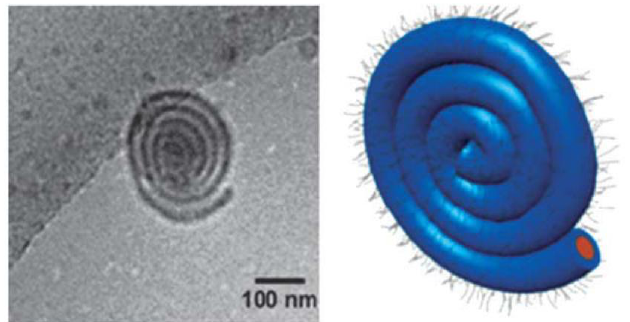
Figure 5. Cryogenic transmission electron micrograph (left) and schematic representation (right) of a spiral-like micellar aggregate formed by a hydrophilic-fluorophilic-lipophilic triblock copolymer in water [82], reproduced by permission of the Royal Society of